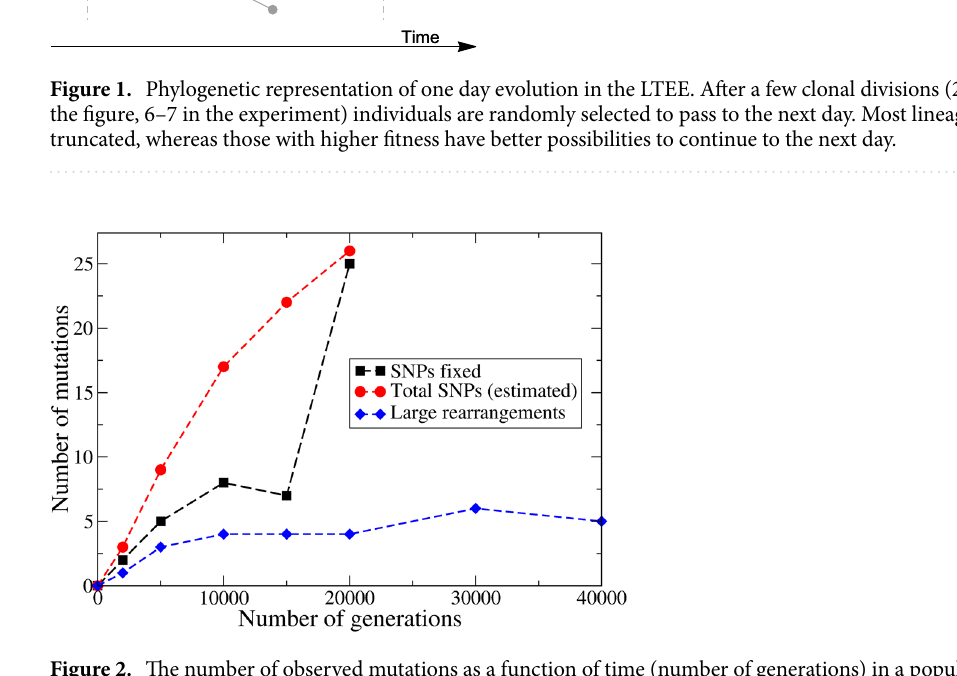
Figure 2. The number of observed mutations as a function of time (number of generations) in a population named Ara-1 of the LTEE 7 . Data from generation 0 (ancestral strain, taken as reference) to 20,000 are included in the figure. Fixed SNPs (black squares), the estimated mean number of SNPs in clones (red dots, coming from calculations in the Supplementary Materials), and the number of large rearrangements (blue diamonds) are